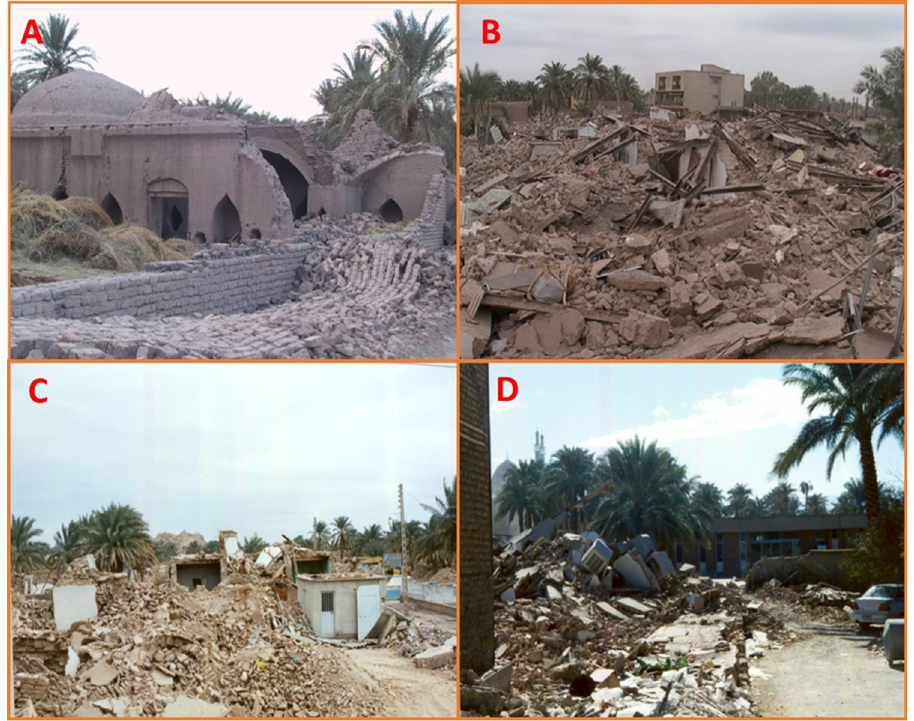
Fig 3. Images of the earthquake destroyed 90% of raw brick-made houses and created a suitable sandfly breeding condition for transmission of anthroponotic cutaneous leishmaniasis in Bam, southeastern Iran (the research team took the above pictures in 2003 following the earthquake of